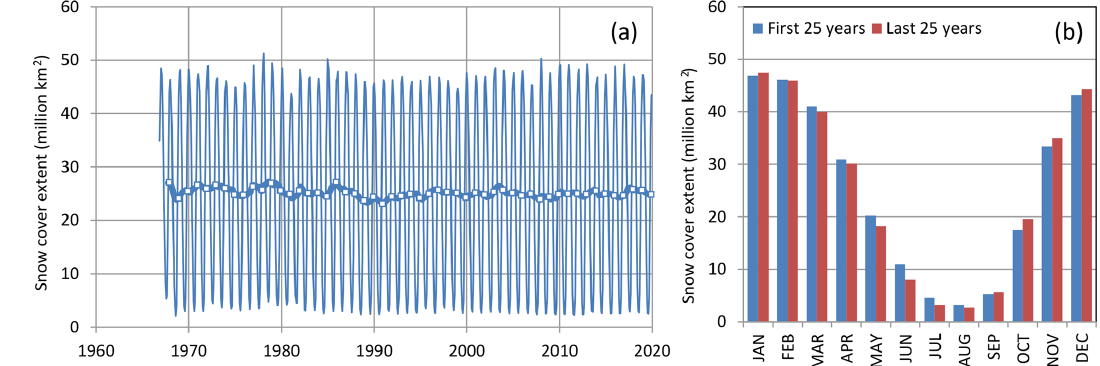
Figure 11. (a) Variation of the snow cover extent in the Northern Hemisphere according to GSL; thin and thick lines represent monthly values and running annual averages (right aligned), respectively, and squares are annual averages aligned in December of each year. (b) Seasonal variation of the snow cover, separately, for the first and last 25 years on